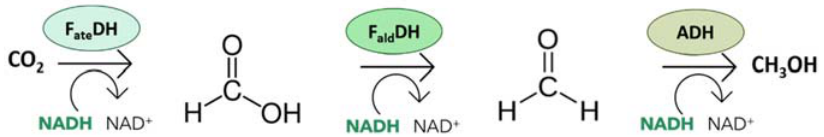
Figure 1. Cascade of reactions for the reduction of CO 2 to CH 3 OH.